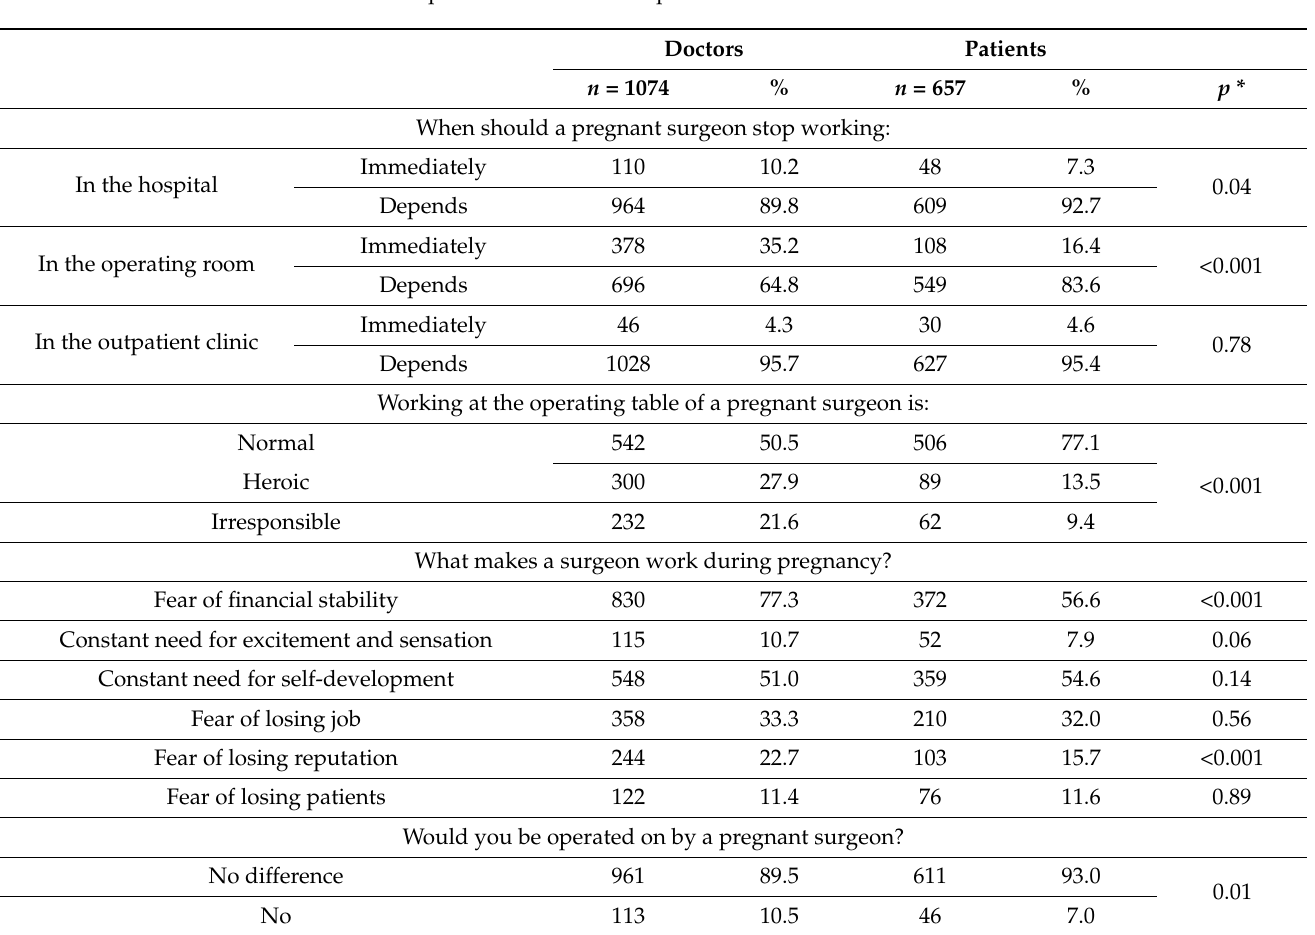
Table 2. Opinions of doctors and